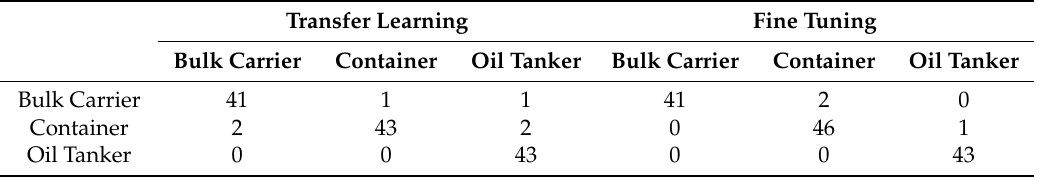
Table 5. Confusion Matrix of the model trained via transfer leaning and fine tuning on validation